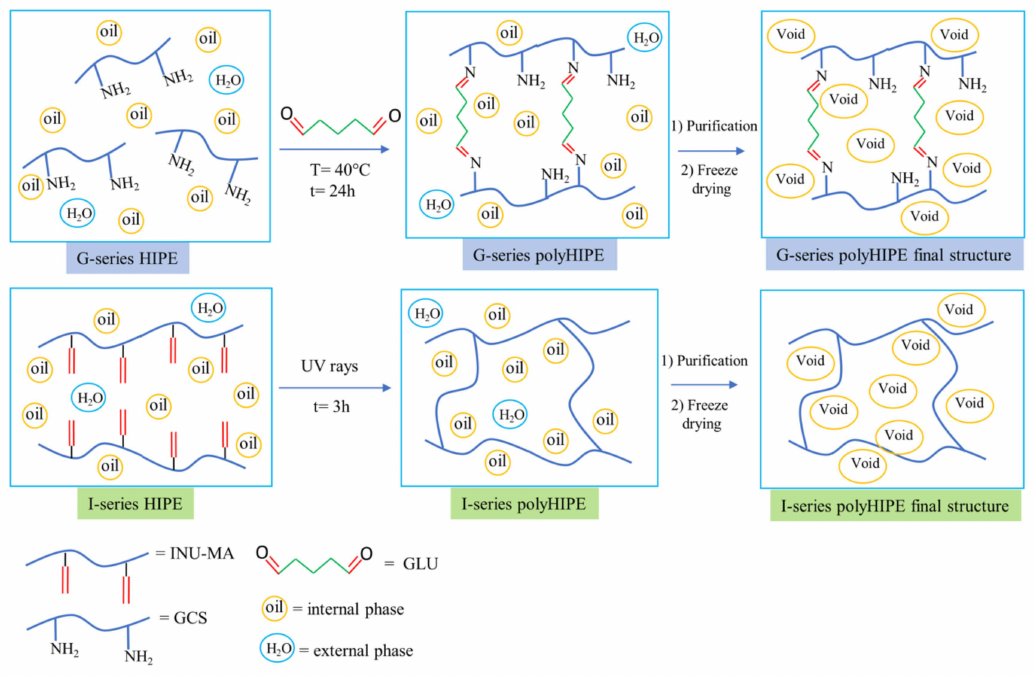
Scheme 1. Schematic representation of G-series and I-series polyHIPE formation, describing from left to right: HIPE formation, polyHIPE formation (crosslinking), and polyHIPE purification and freeze drying.